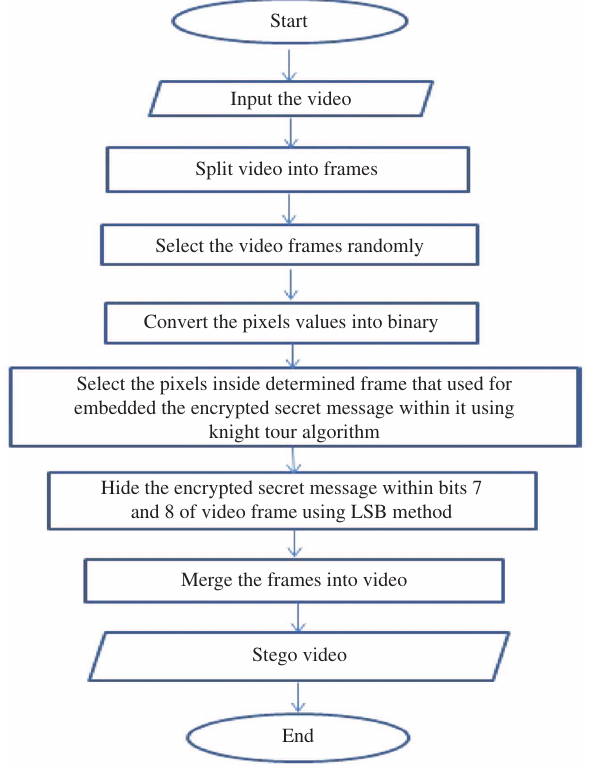
Figure 2: The Flow Chart of Embedding Process.